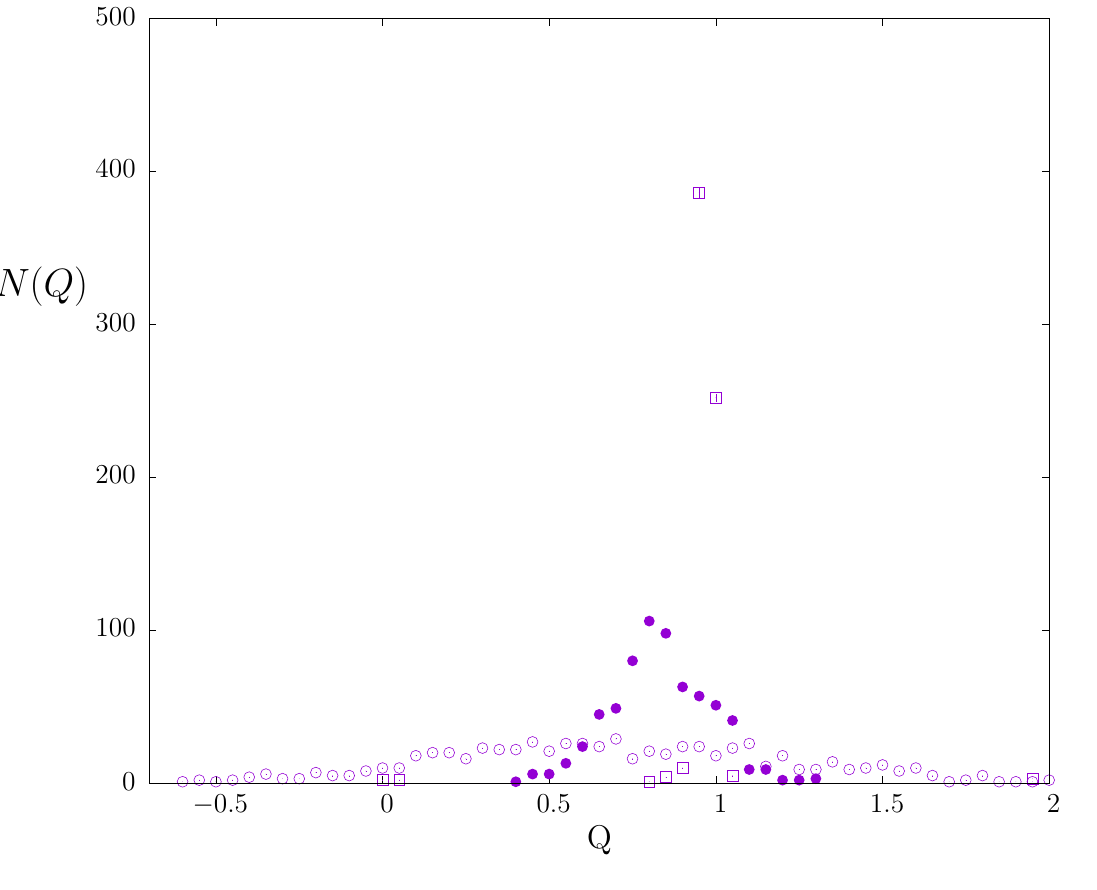
Figure 29 . Histogram of Q for fields with Q ∈ [ − 0 . 40 , 1 . 35] after 2 cooling sweeps, • . For the same fields a histogram for Q after 1 cooling sweep, ◦ , and after 20 cooling sweeps, (cid:3) . Points corresponding to N ( Q ) = 0 are